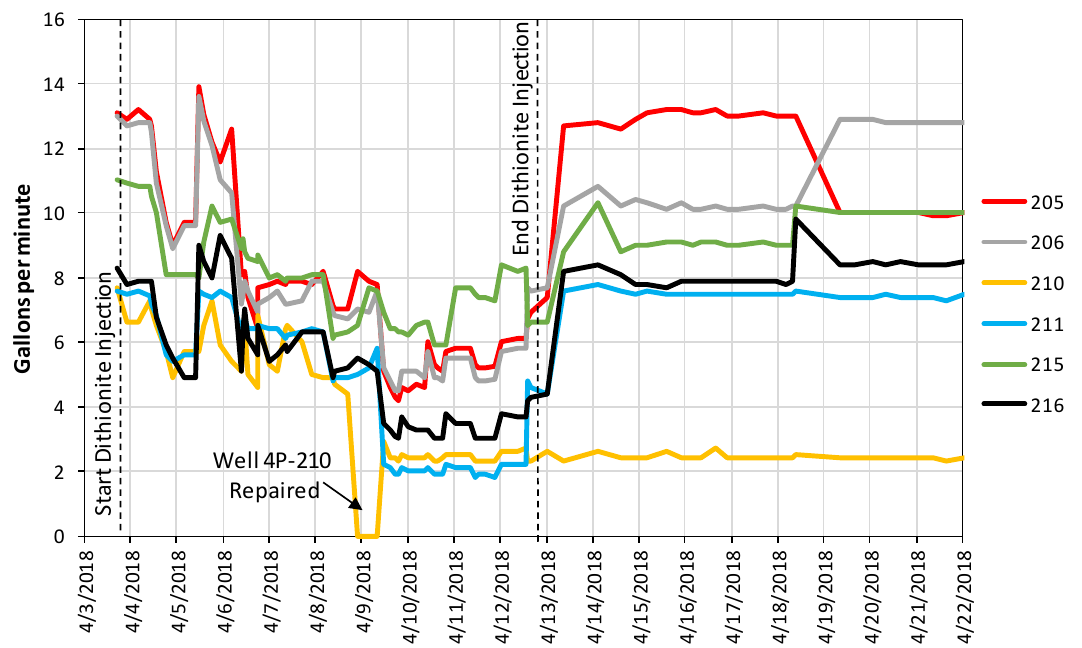
Figure A15. Production well flows during and for some time after dithionite injection.